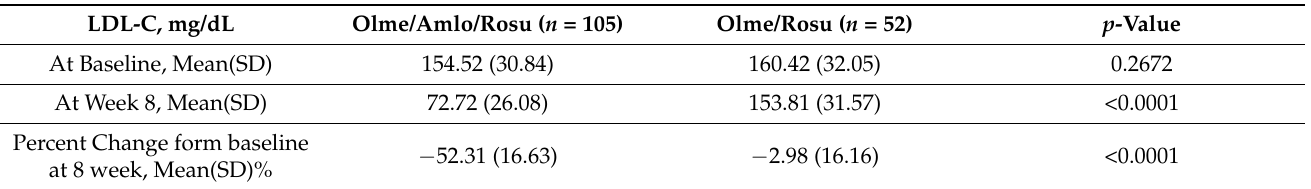
Table 3. Change of LDL-C at 8 weeks comparing olme/amlo/rosu and olme/amlo